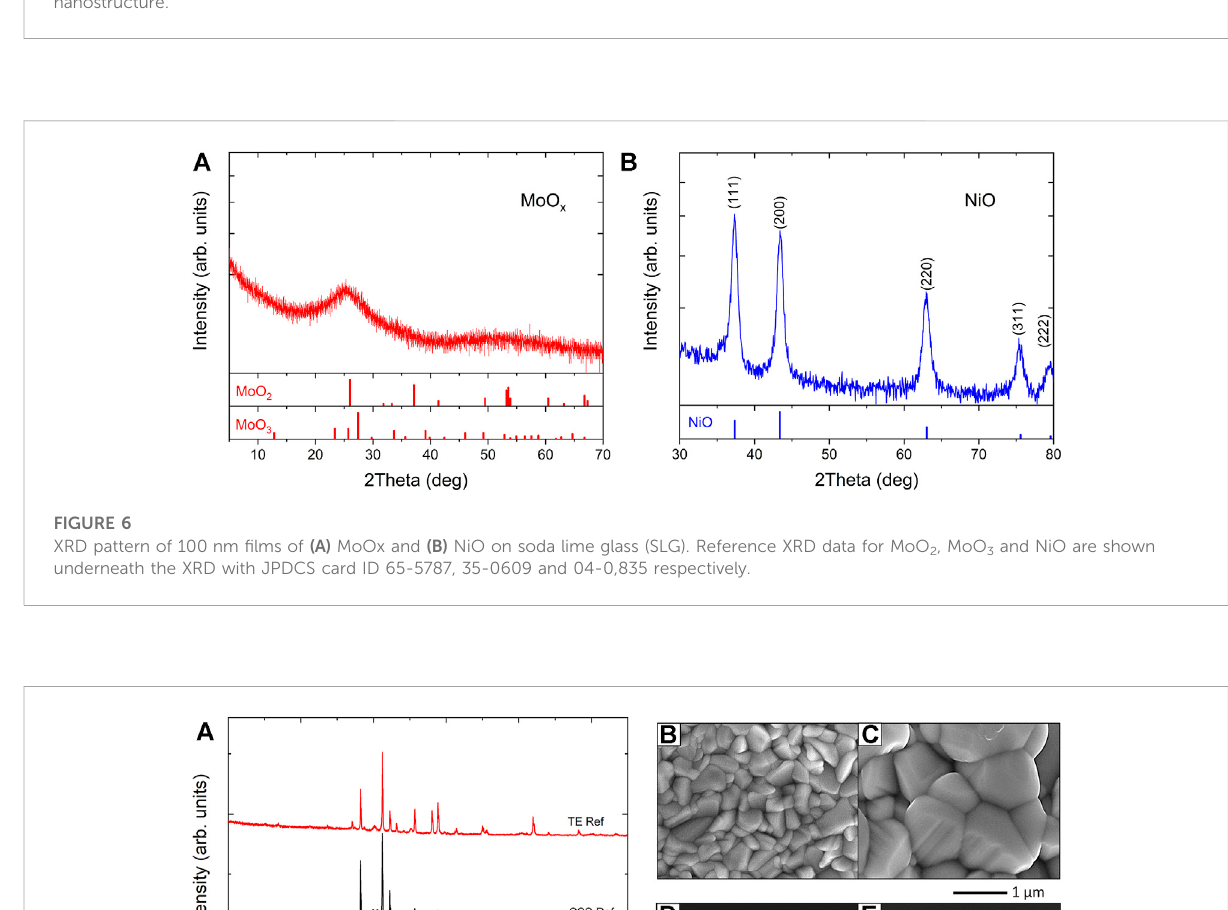
FIGURE 5 Top-down SEM image of a 100 nm (A) MoO x fi lm and (B) NiO fi lms on glass. Inset: Higher magni fi cation image of the NiO fi lm, showing the nanostructure.